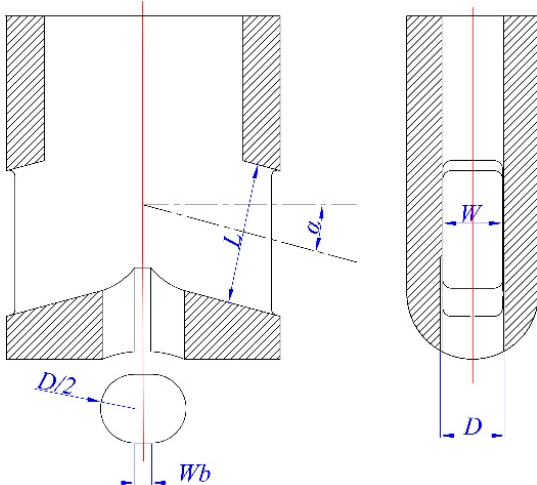
Figure 1. Schematic of the water model and measurement positions of mean wave height.